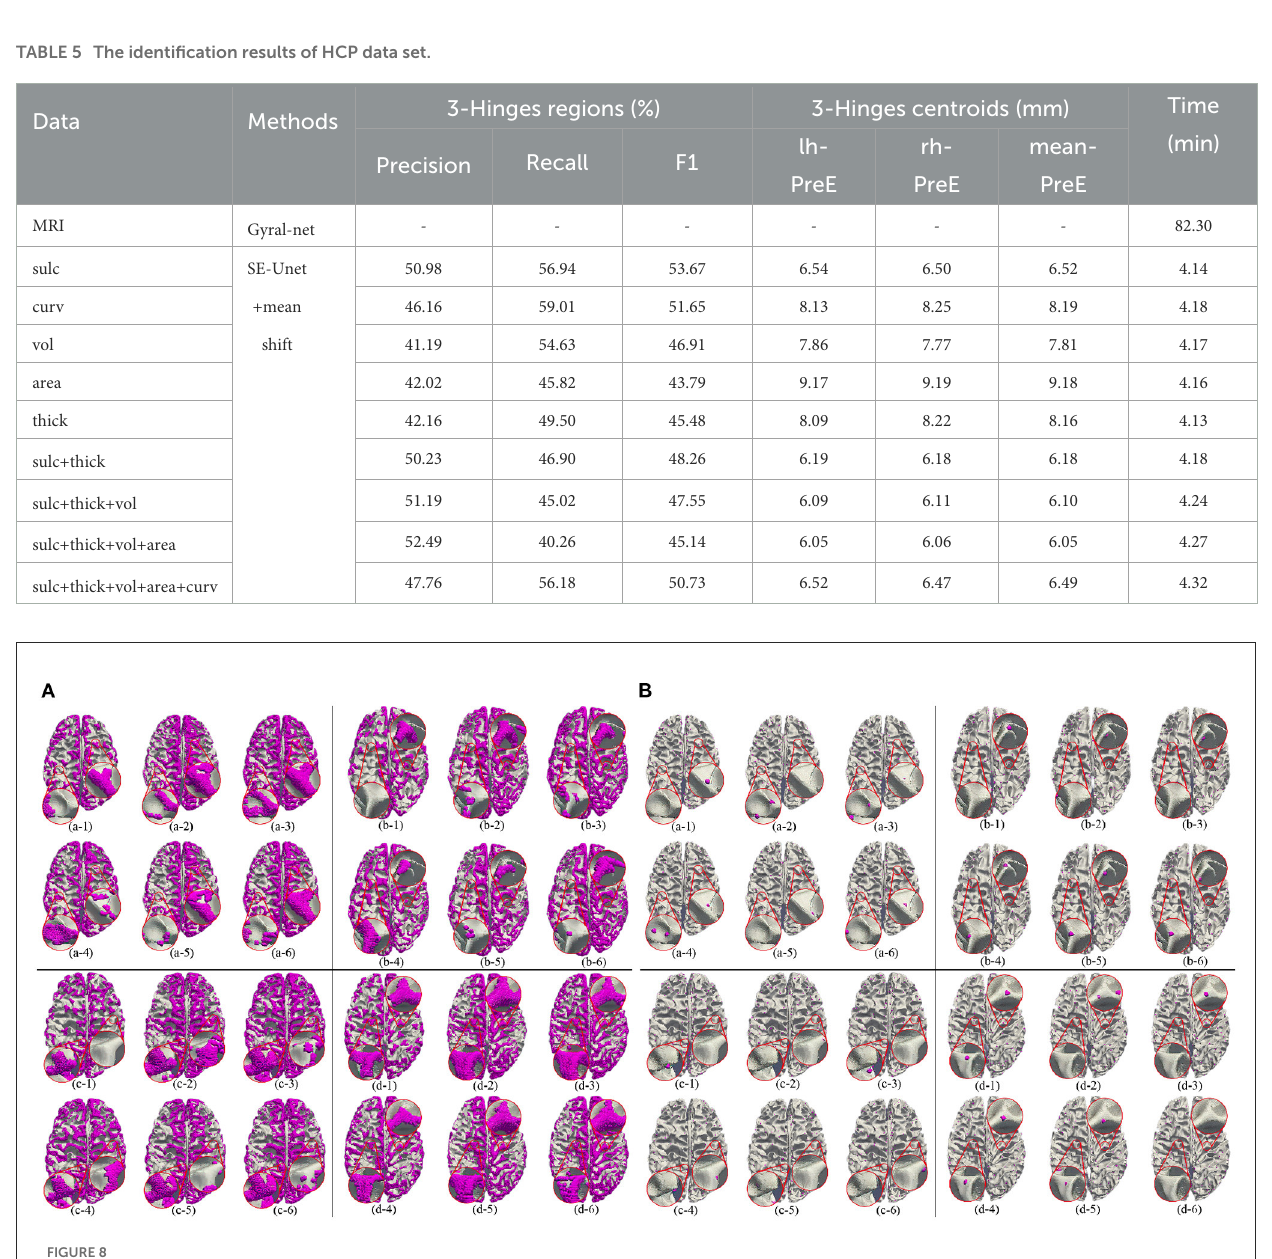
FIGURE8 3-Hinges regions (A) /centroids (B) visualized results using different features on HCP. Letters (a–d) represent different individuals. Numbers (1–6) indicate label, area, curv, sulc, thickness, and volume,